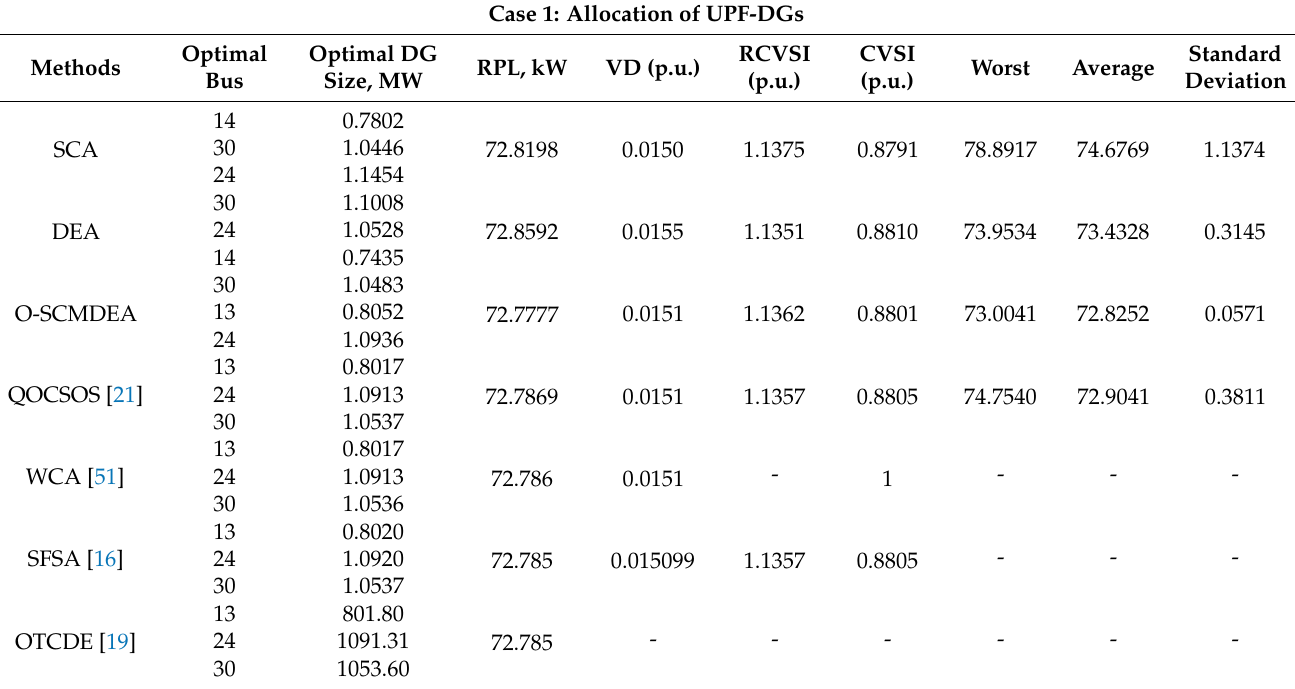
Table 4. Comparison of the results for the real power loss minimization of 33 bus DN. Case 1: Allocation of